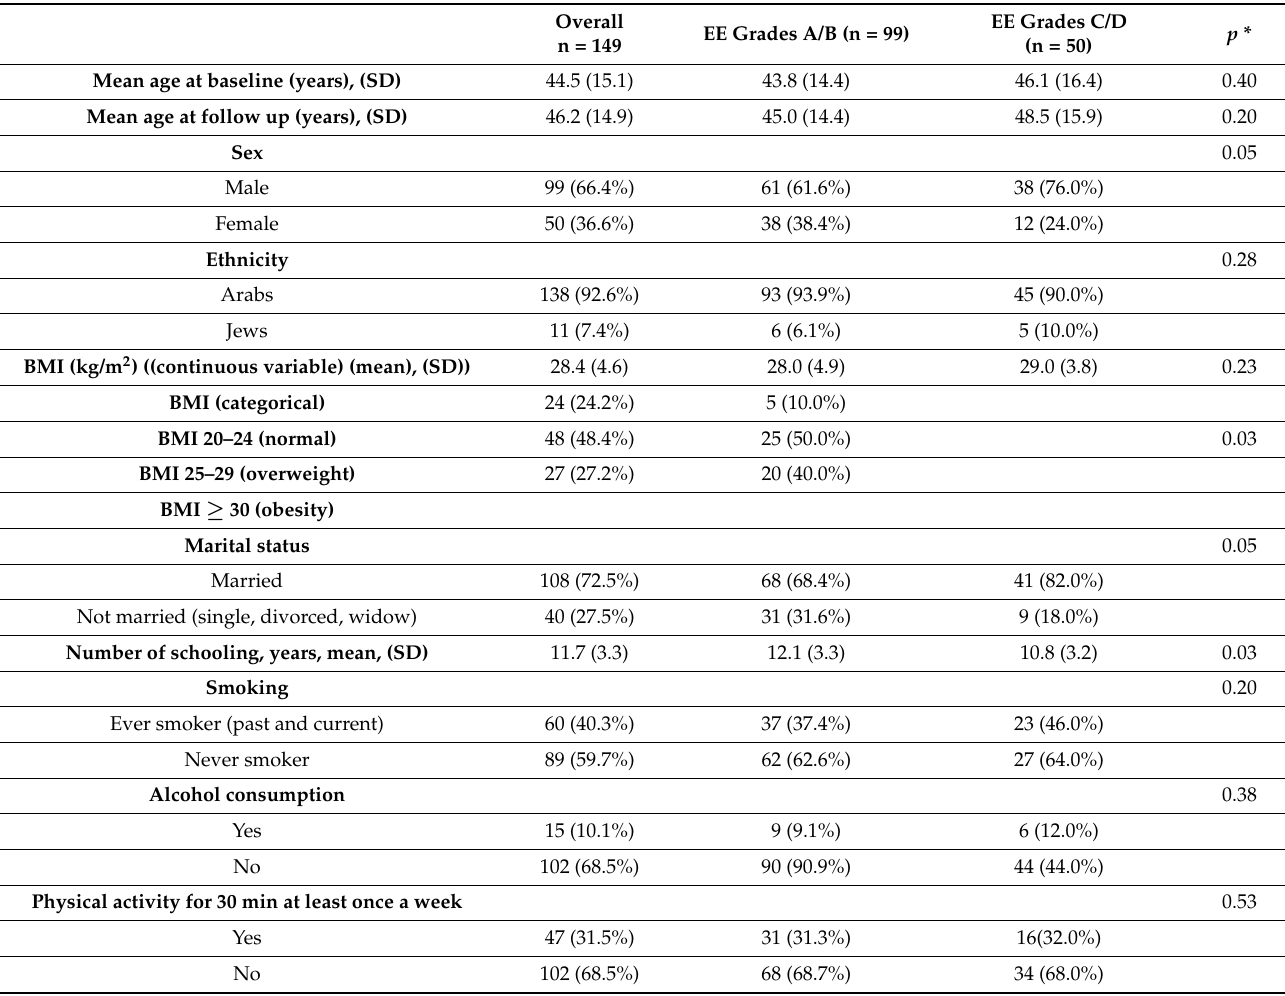
Table 1. Description of the study